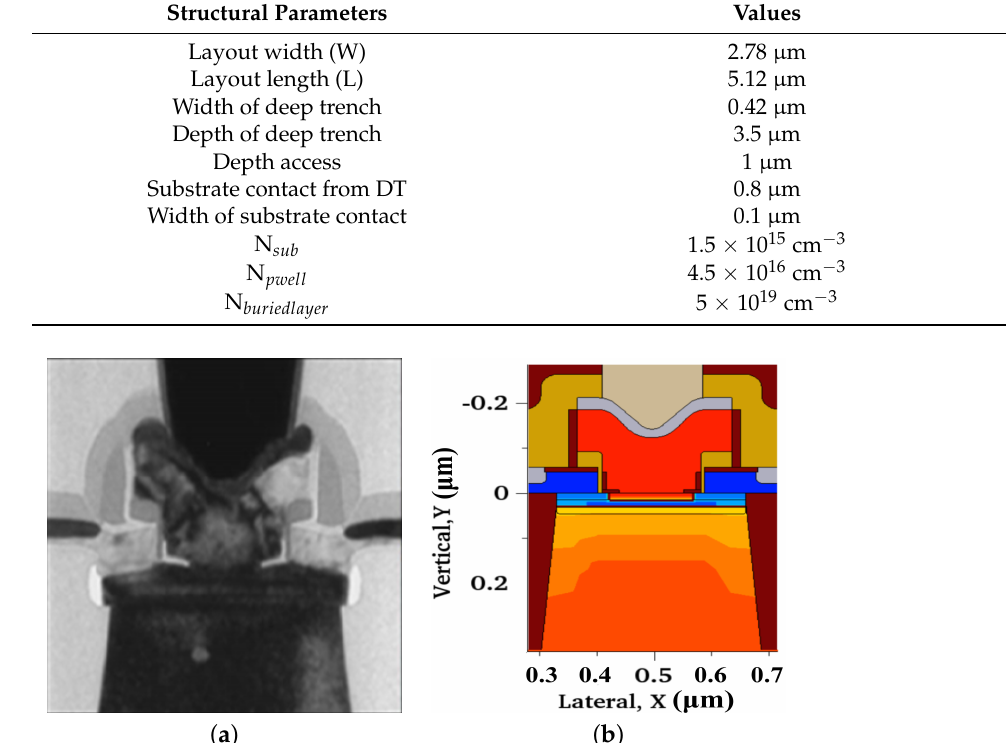
Figure 2. SiGe HBT device structure: ( a ) TEM image [21] and ( b ) structure made in sentaurus